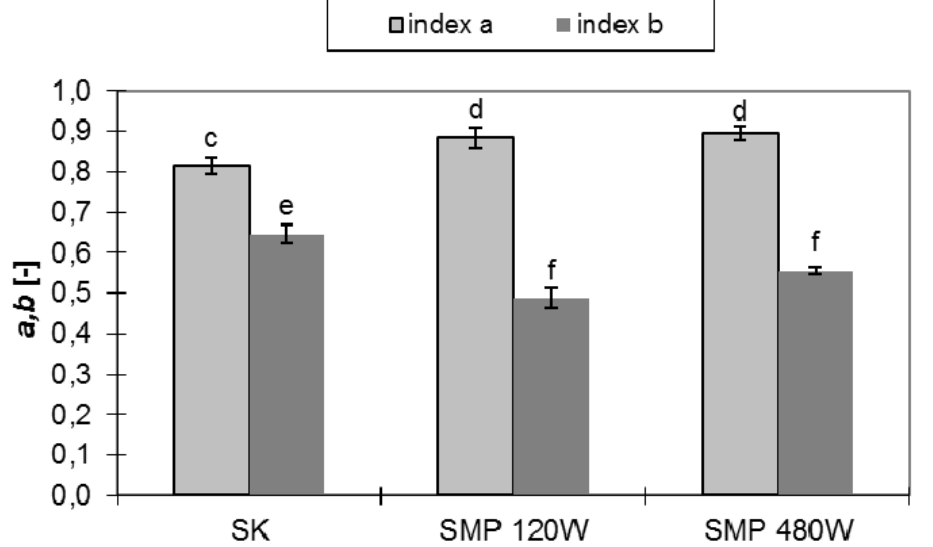
Figure 3. Values of a and b indexes for dried Physalis. SK—convective method; SMP—microwave method under reduced pressure 120 W and 480 W; Mean values with different letters (a, b, c) within the same columns are statistically different ( p = 0.05).